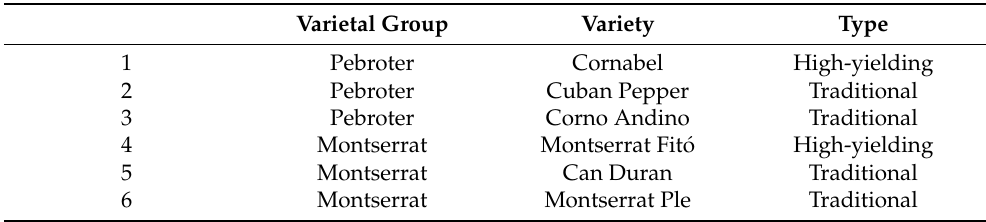
Table 1. Selected tomato varieties.